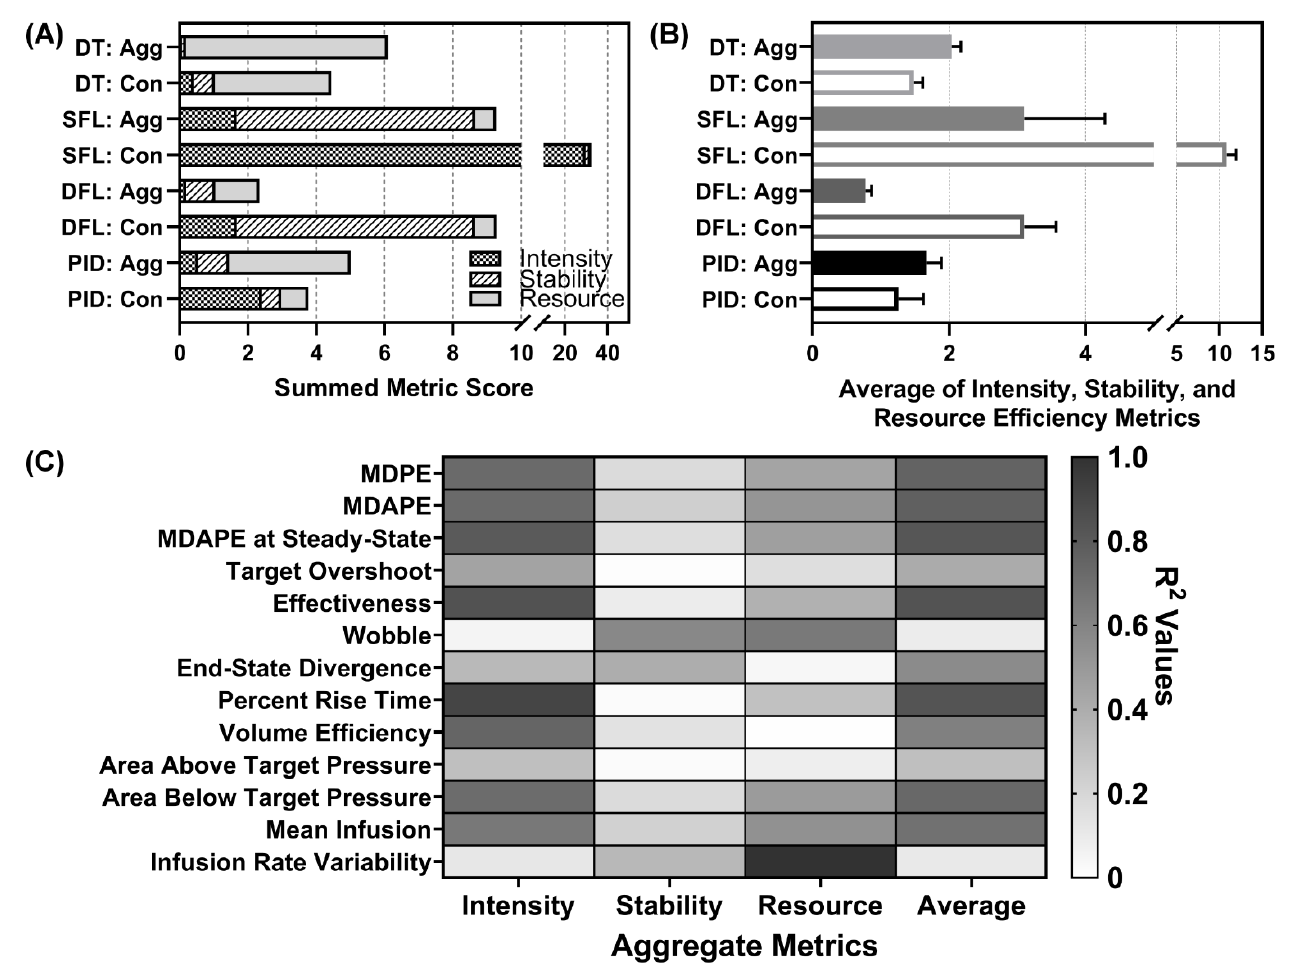
Figure 9. Average metric scores and correlation. ( A ) Stacked bar graph for all three aggregate metrics to highlight the various scores for each controller type (DT = decision table; SFL = single-input fuzzy logic; DFL = dual-input fuzzy logic; PID = proportional – integral – derivative controller) and configuration (Agg = aggressive; Con = conservative) (lower is better). ( B ) Average metric of intensity, stability, and resource efficiency metrics for each controller type and configuration (lower is better). Note the broken x -axis for each plot. ( C ) Correlation matrix for each individual performance metric vs. intensity, stability, and resource efficiency metrics. In addition, correlations were performed against the average aggregate metric score. Heat map colors reflect R 2 values for each linear fit correlation, with darker grey indicating a stronger correlation.